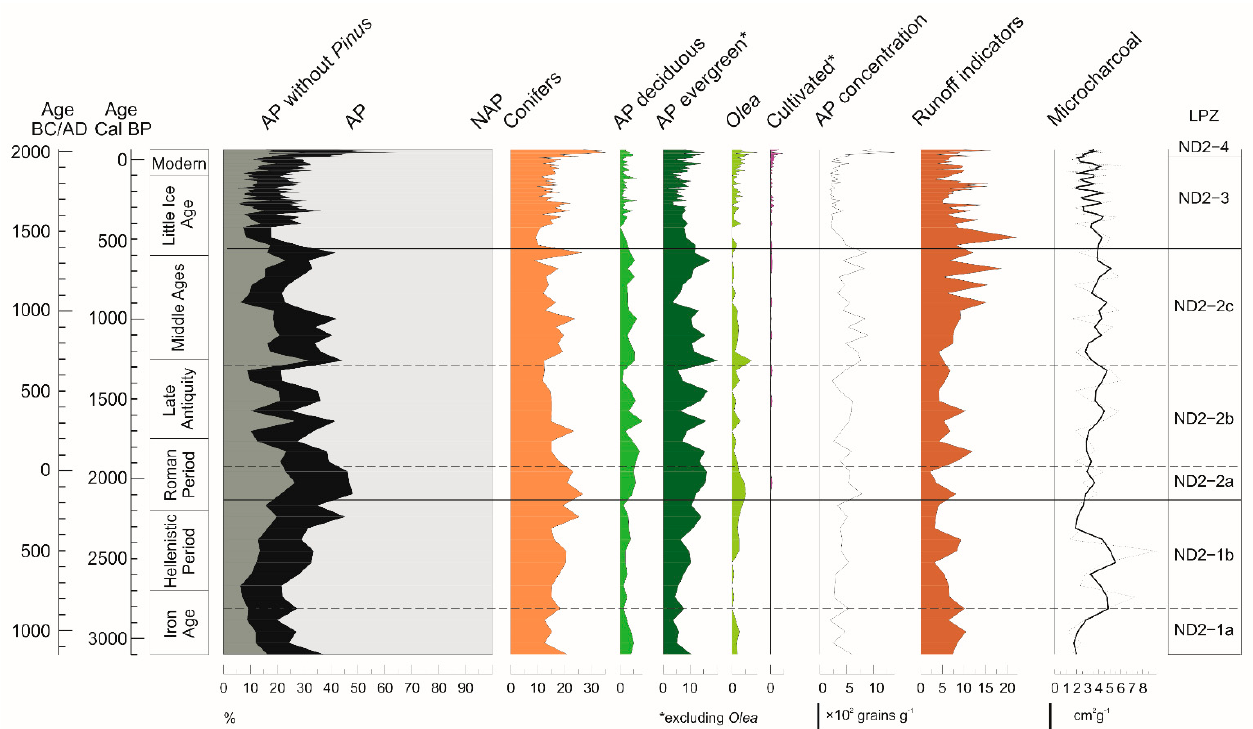
Figure 4. Summary pollen percentage diagram, including cumulative percentages of conifers ( Abies , Cedrus , and Pinus ), deciduous trees (mostly deciduous Quercus , Alnus , Ostrya / Carpinus orientalis , Fraxinus , and Corylus ), evergreen trees and shrubs (mostly evergreen Quercus , Quercus suber type, Phillyrea , Pistacia , and Ericaceae), cultivated trees ( Castanea , Juglans , Citrus , Vitis , and Eucalyptus ), arboreal pollen %, Olea , runoff indicators ( Pseudoschizaea and Glomus type), and microcharcoal concentration. The asterisk (*) indicates that Olea is excluded from the ecological group.